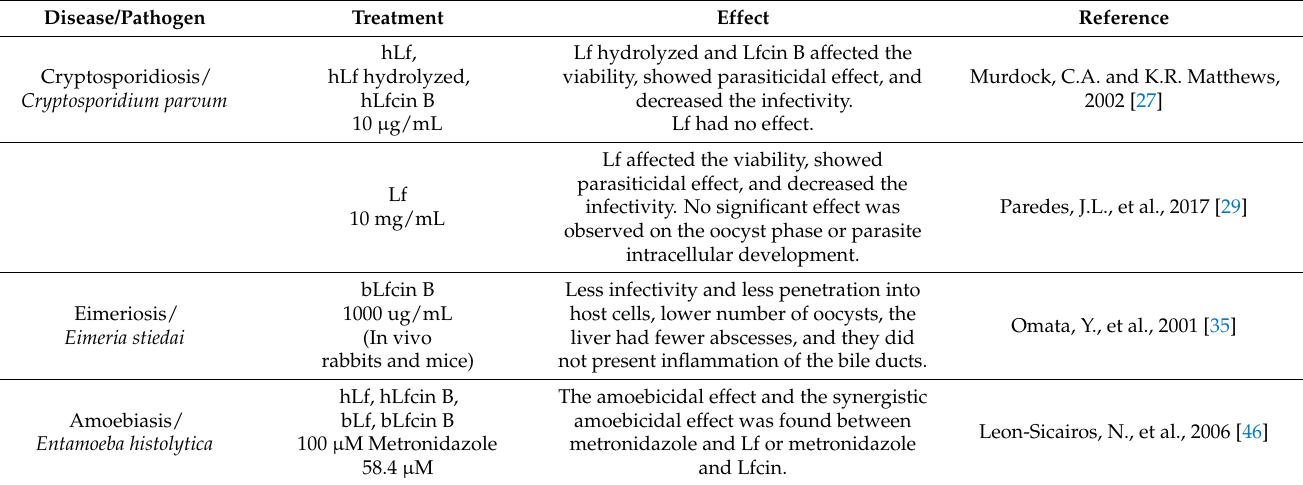
Figure 2. Effect of Lactoferricins on protozoa. Lactoferricins are antimicrobial peptides derived from the N-terminus of Lactoferrin. It has been reported that the effect of Lfcins is higher than that of the native protein. In the image, the activity of Lfcins towards each pathogen is specified. * Lfchimera consists of a fusion of Lfcin 17–30 and Lfampin 265–284. Table 1. Effect of Lactoferrin and its peptides on diseases caused by pathogenic